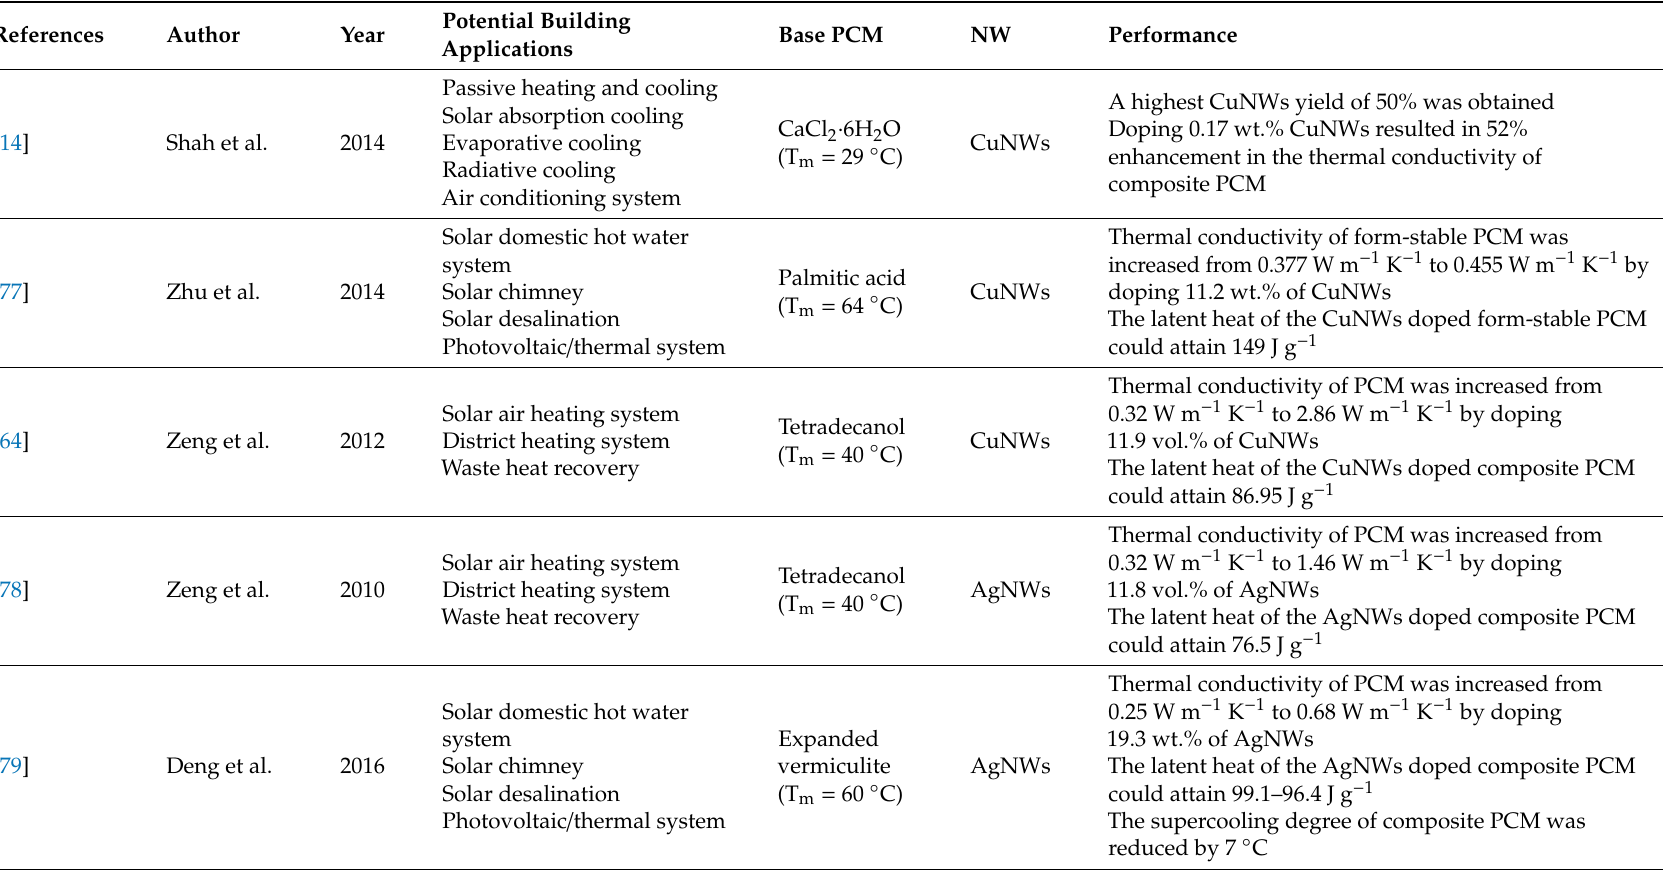
Table 2. Summary of metallic NWs for thermal conductivity enhancement of phase change material